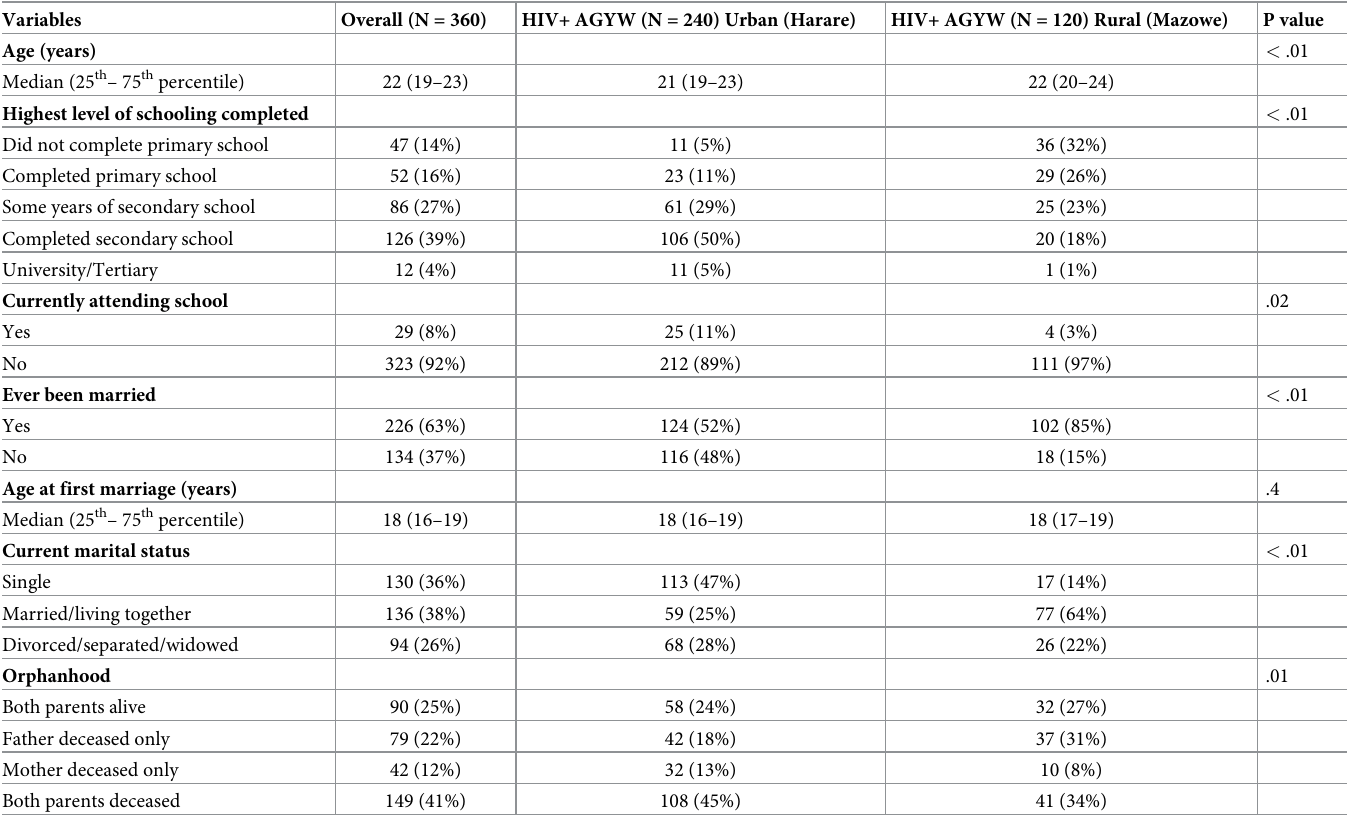
Table 1. Sociodemographic characteristics of HIV-positive adolescent girls and young women by